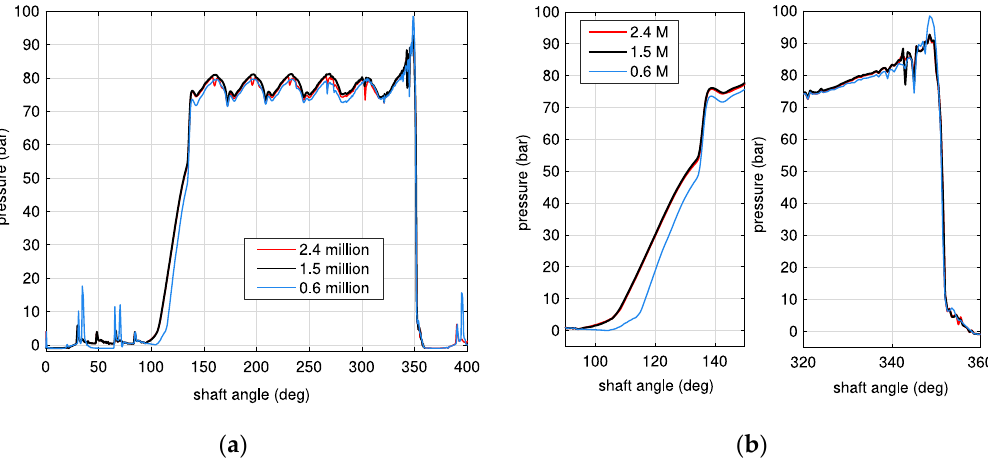
Figure 7. ( a ) Tooth space pressure history at 1250 rpm with three different mesh densities; ( b ) Details in correspondence of the transition between high and low pressure levels.